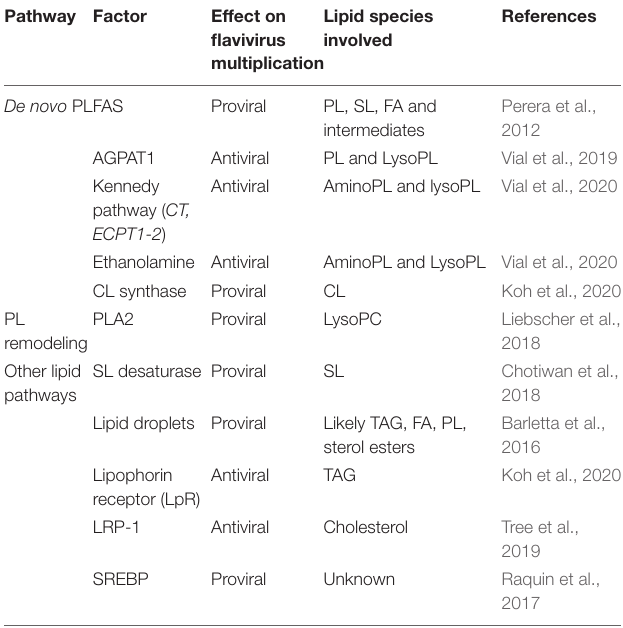
TABLE 1 | Functions of lipid-related mosquito factors in flavivirus infection. Pathway Factor Effect on multiplicationLipid species flavivirus